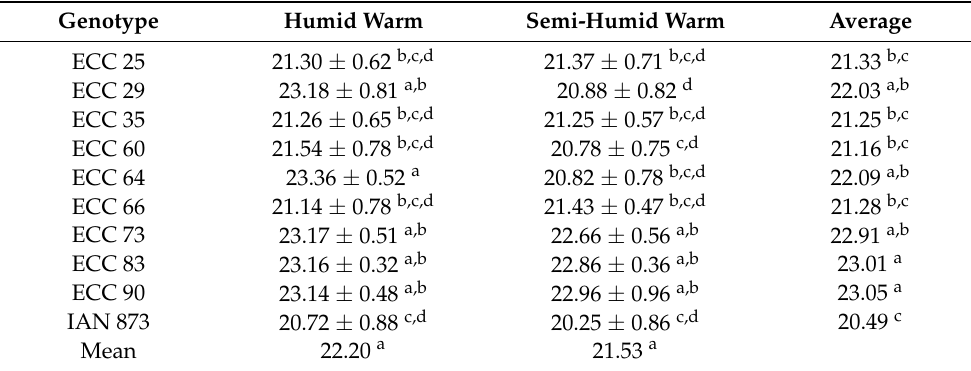
Table 4. Girth (cm) of nine Hevea brasiliensis genotypes from the ECC-1 ( É lite Caquet á Colombia) selection and IAN 873 cultivar (control) after one year of growth (i.e., 3-year-old trees) at two sites with different climates in Caquet á (Northwestern Colombian